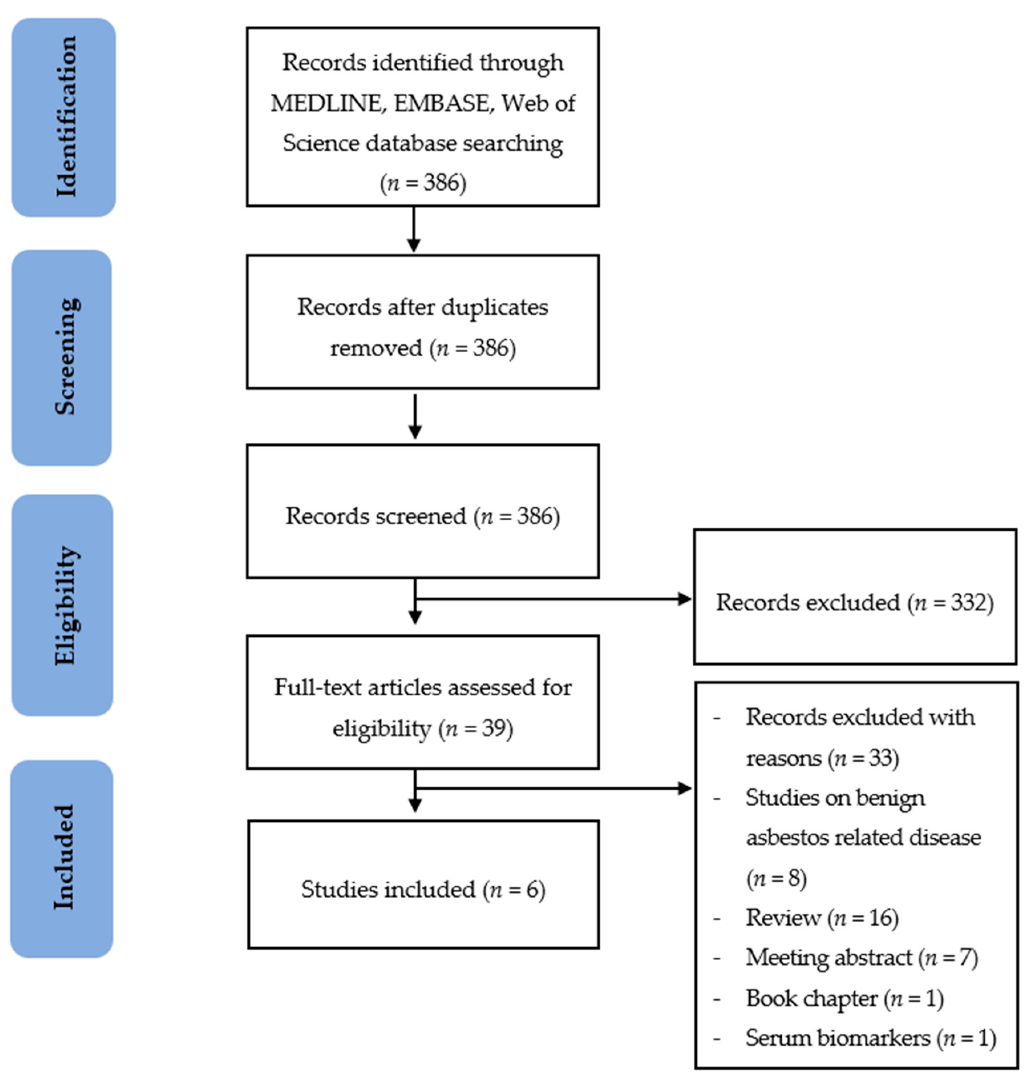
Figure 3. Flow chart of the study selection process.